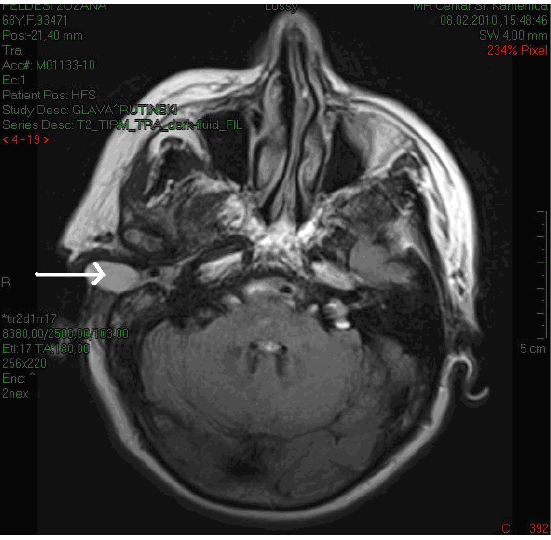
Figure 3. MRI showing an ovoid, expansive, well-defined soft- tissue lesion, 11x21 x12 mm in size, (AP x LL x CC) in the right EAC.